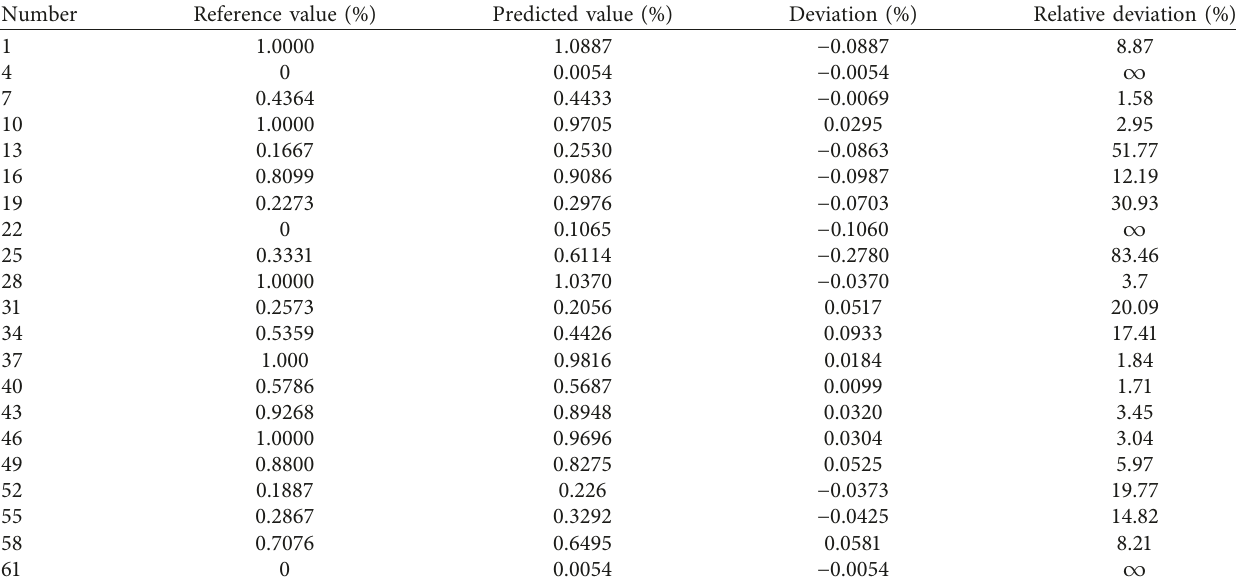
Figure 7: RMSECV-rank correlation diagram (a) and the prediction results of the model for the training set (b) and prediction set (c). Table 5: Predicted T values of prediction set samples.